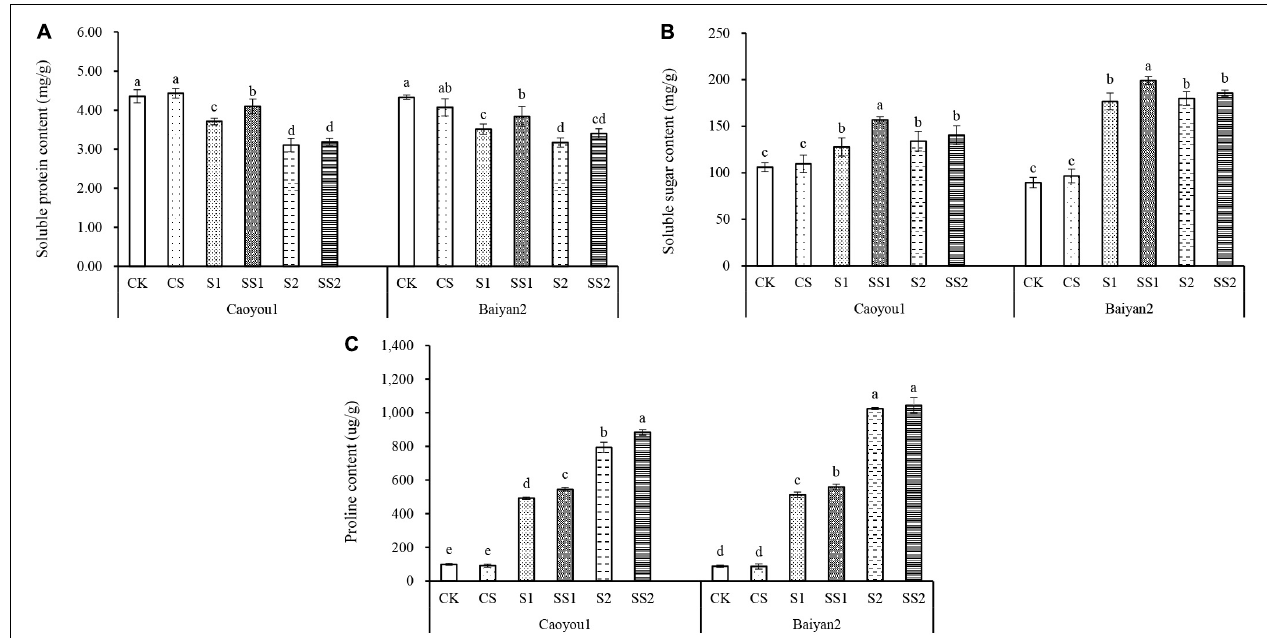
FIGURE 5 | Effects of Spd application on soluble protein (A) , soluble sugar (B) , and proline contents (C) under salt stress in the oat seedlings. CK, Nutrient solution + distilled water; CS, Nutrient solution + 0.75 mM Spd; S1, 70 mM salt + distilled water; SS1, 70 mM salt + 0.75 mmol/L Spd; S2, 100 mM salt + distilled water; SS2, 100 mM salt + 0.75 mmol/L Spd; Different lowercase letters indicate significant differences between treatments at 0.05